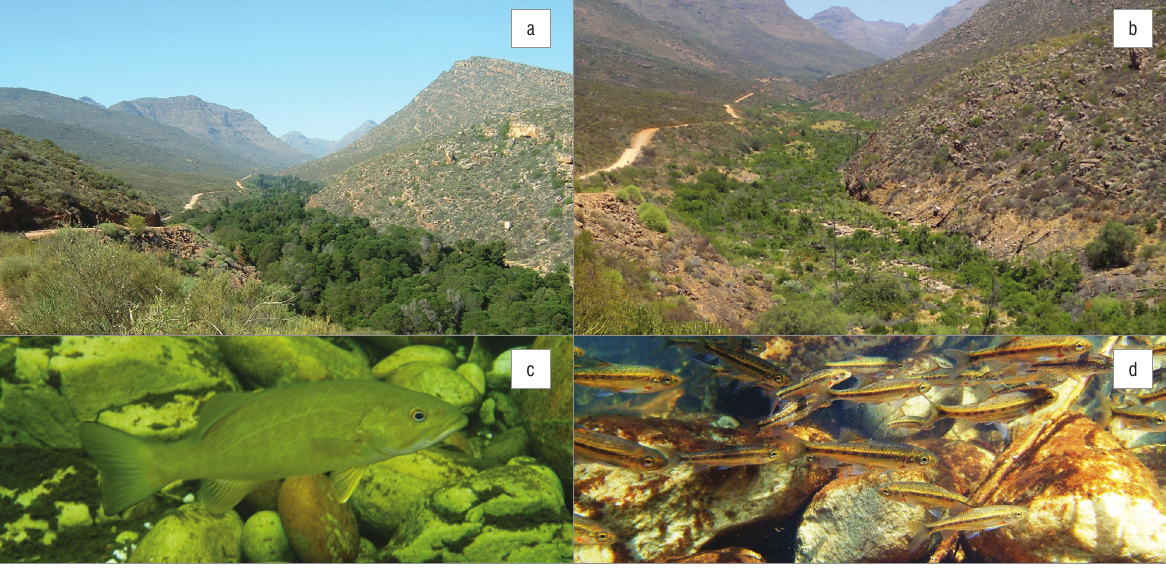
Photos: (a) D Woodford; (b-d) ND Impson.